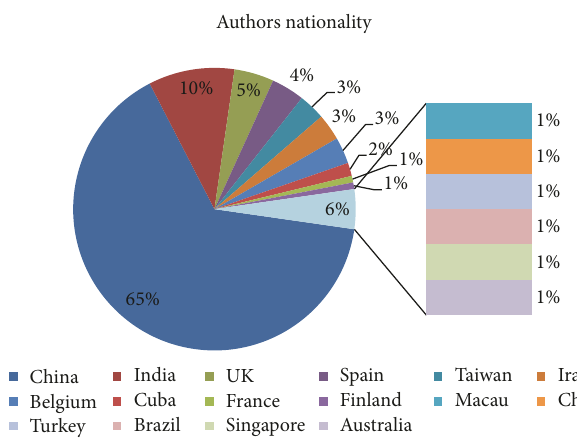
Figure 5: Distribution of papers based on nationality of